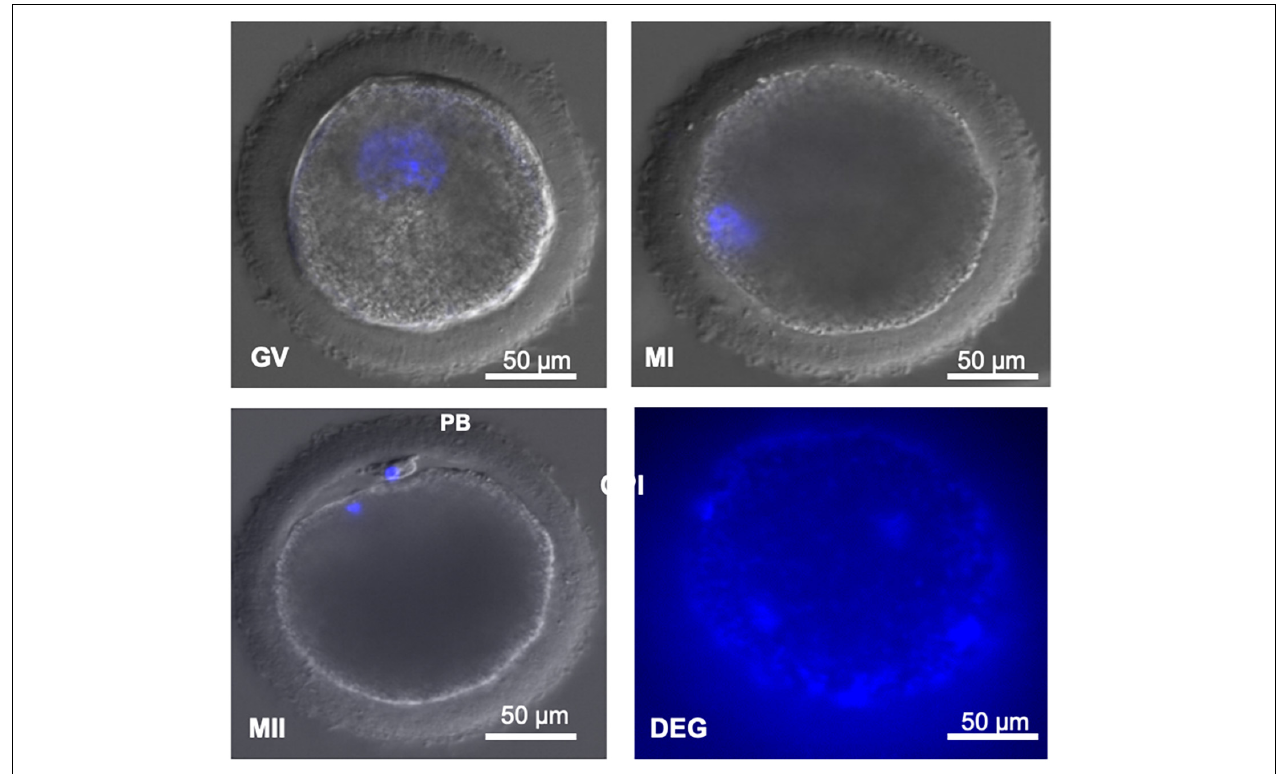
FIGURE 2 | (GV) Decondensed DNA contained in a large germinal vesicle. (MI) Condensed DNA. (MII) Condensed DNA and presence of the first polar body. (PB) First polar body. Degenerated (DEG) oocytes without identifiable material. Image obtained under confocal microscope (magnification × 400). Scale bar: 50 µ m.